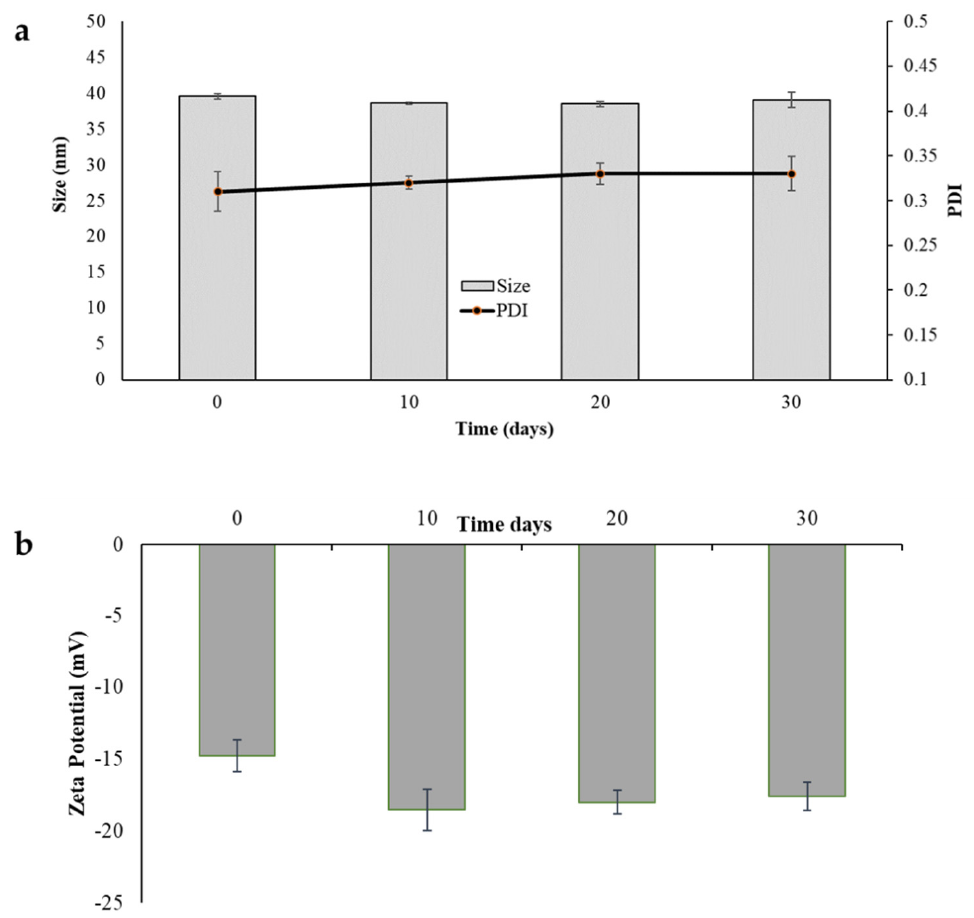
Figure 5. Freeze-dried micelles (UA–PML) stored for 30 days at 25 °C. ( a ) Particle size and polydispersity index after reconstitution of the colloidal dispersion (PDI). ( b ) Zeta potential after reconstitution of the colloidal dispersion. Data are shown as mean ± SD ( n = 3).